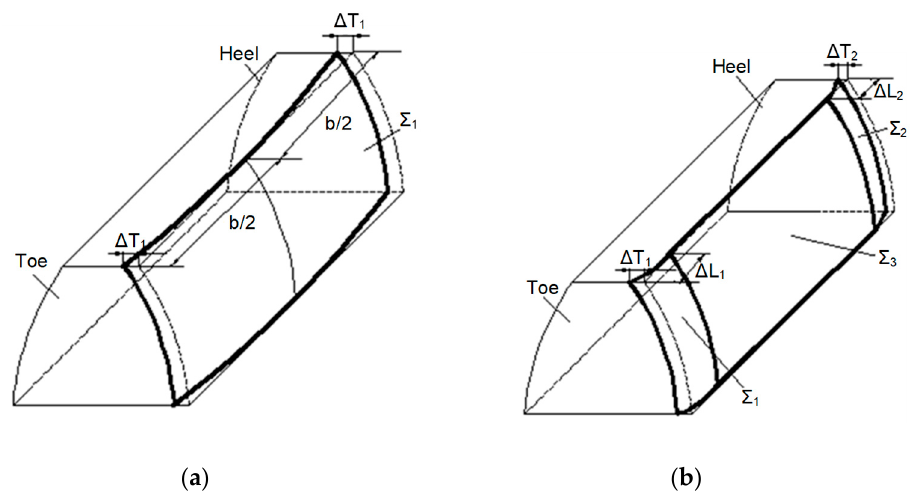
Figure 6. ( a ) Symmetric crowned modification; ( b ) tooth end relief.